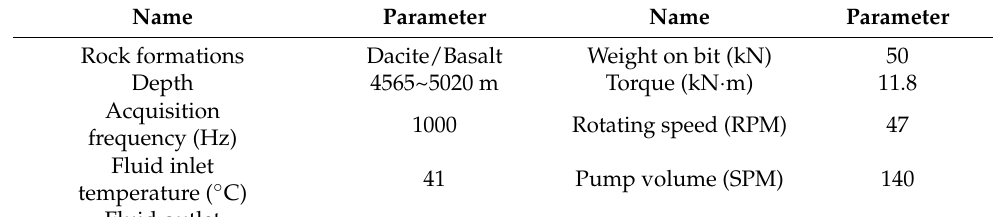
Table 3. Sensor acquisition parameters and field working conditions.